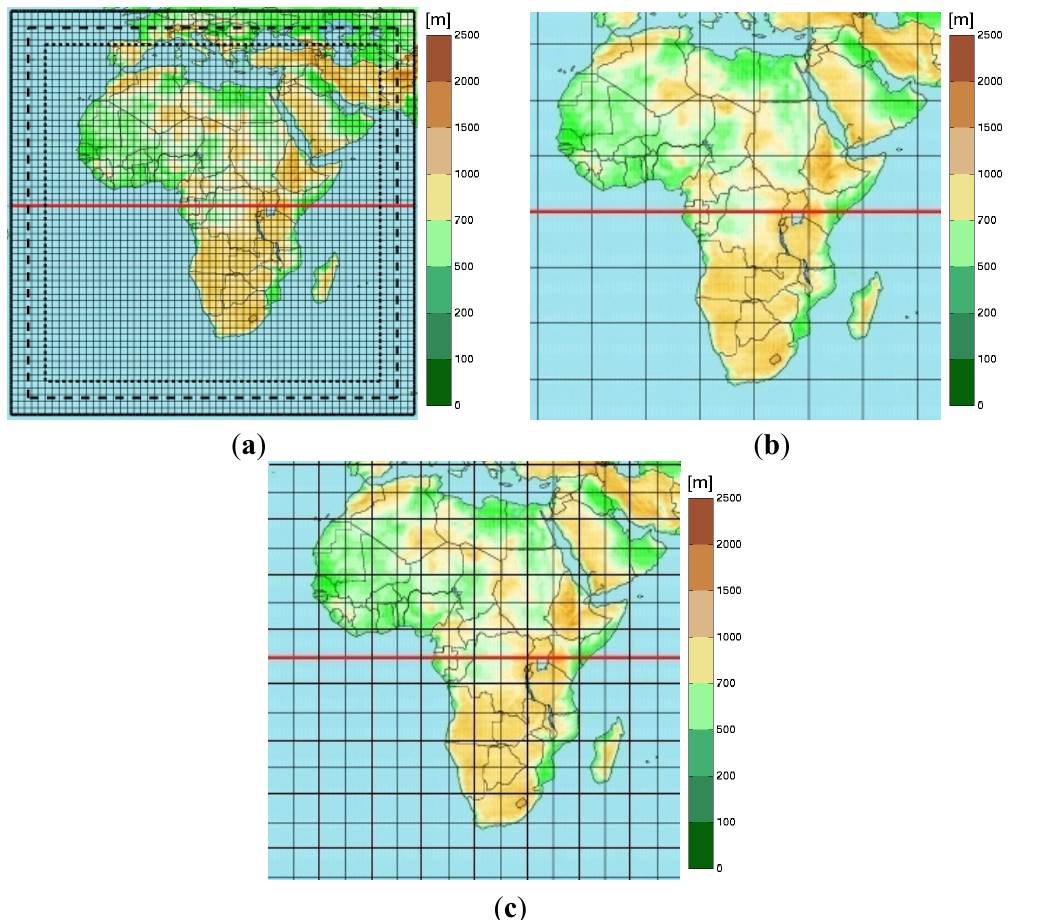
Figure 1. African simulation domain for (a) the fifth generation Canadian Regional Climate Model (CRCM5) at 0.44 o horizontal resolution, with only every fifth grid box displayed. The dashed lines represent the 10 grid-point nesting zone and the dotted line represents the domain of interest. The (b) Canadian Earth System Model (CanESM2) grid at 2.81° horizontal resolution and (c) Global Precipitation Climatology Project (GPCP) grid at 1° horizontal resolution is also shown. The red horizontal line represents the